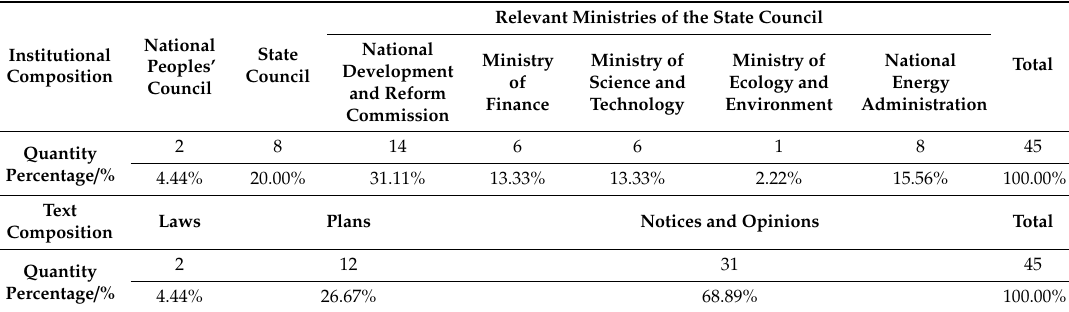
Figure 4. Policy networks of biodiesel policies. Table 6. Institutional and text composition of policies on the development of biodiesel.